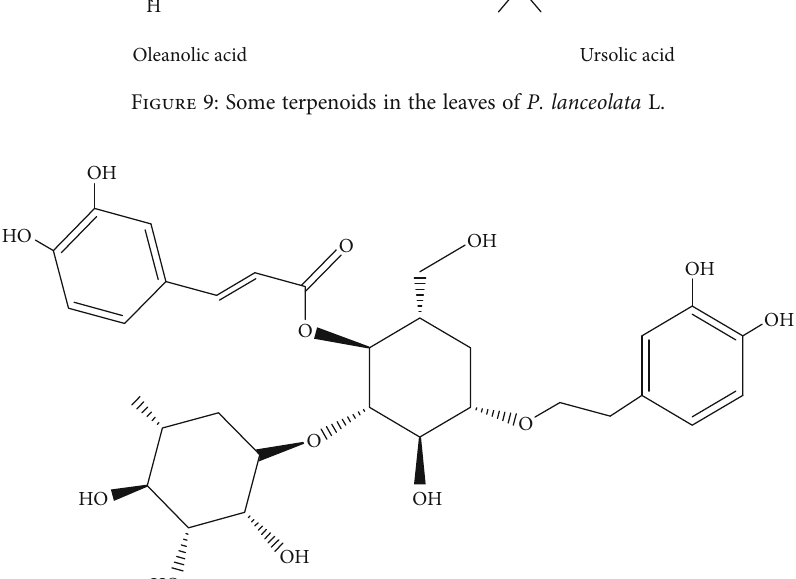
Figure 10: Structure of